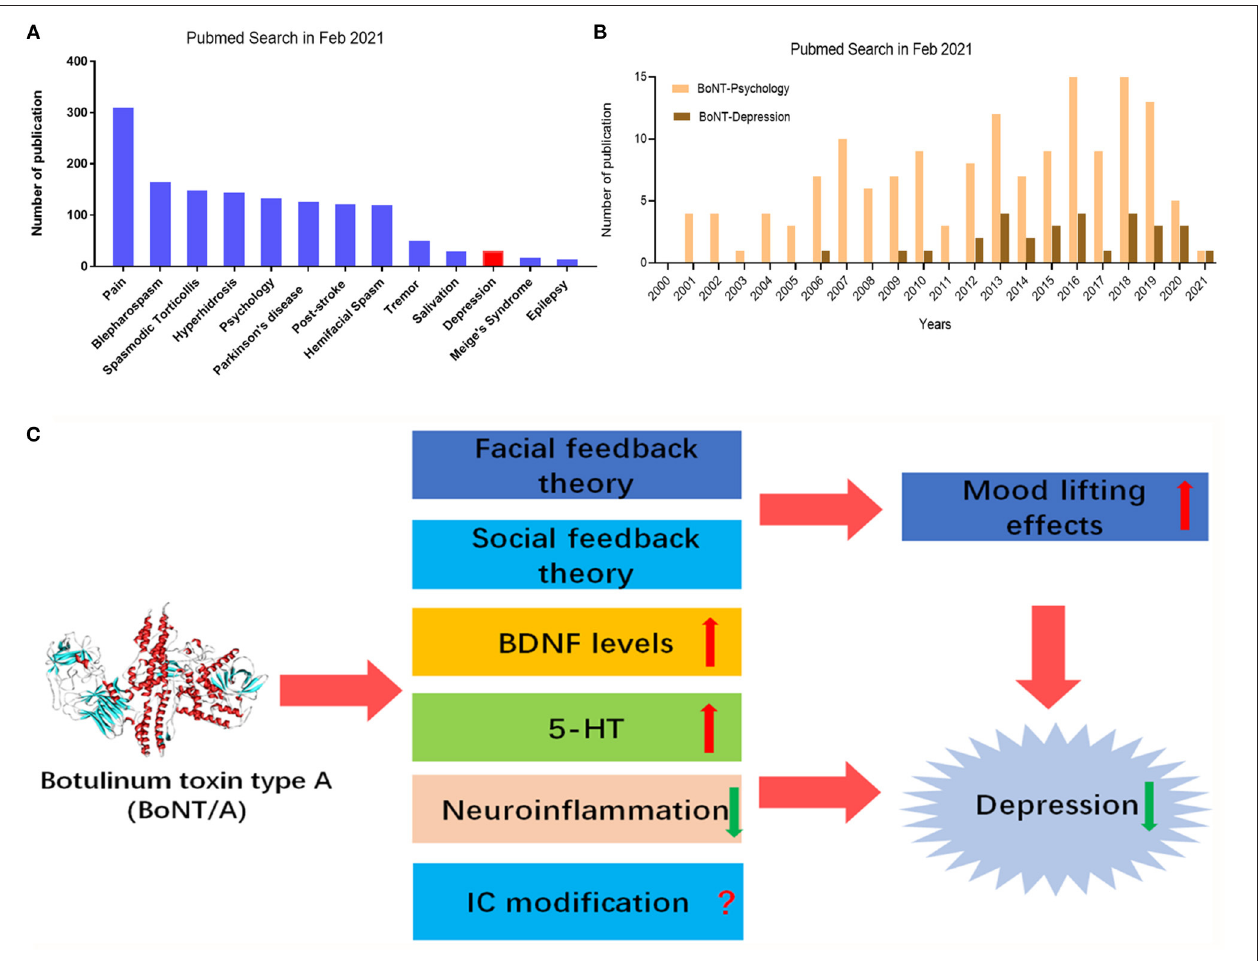
FIGURE 1 | PubMed search for BoNT/A and neurological diseases, including depression. (A) Number of publications applying BoNT/A in Parkinson’s disease, pain, hyperhidrosis, post-stroke, tremor, salivation, epilepsy, spasmodic torticollis, hemifacial spasm, blepharospasm, Meige’s Syndrome, depression, and psychology. (B) Number of publications for applying BoNT/A in depression and psychology in the last 20 years. (C) Therapeutic mechanisms of BoNT/A in depression. Peripheral injection of BoNT/A produces antidepressant effects possible though multiple mechanisms, such as facial feedback and/or social feedback to lift mood, IC modifications, up-regulation of BDNF levels, increasing 5-HT levels, and dampening neuroinflammation. IC, insular cortex; BDNF, brain-derived neurotrophic factor; 5-HT,